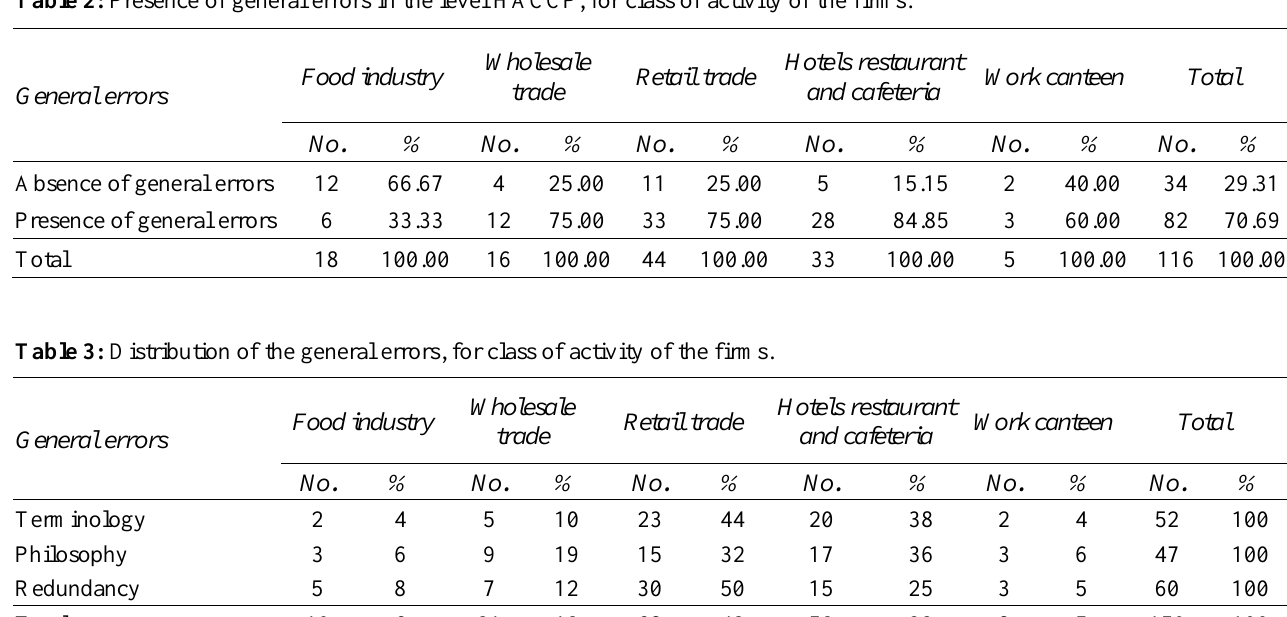
Table 4: Distribution of the general errors, for class of activity of the food companies.